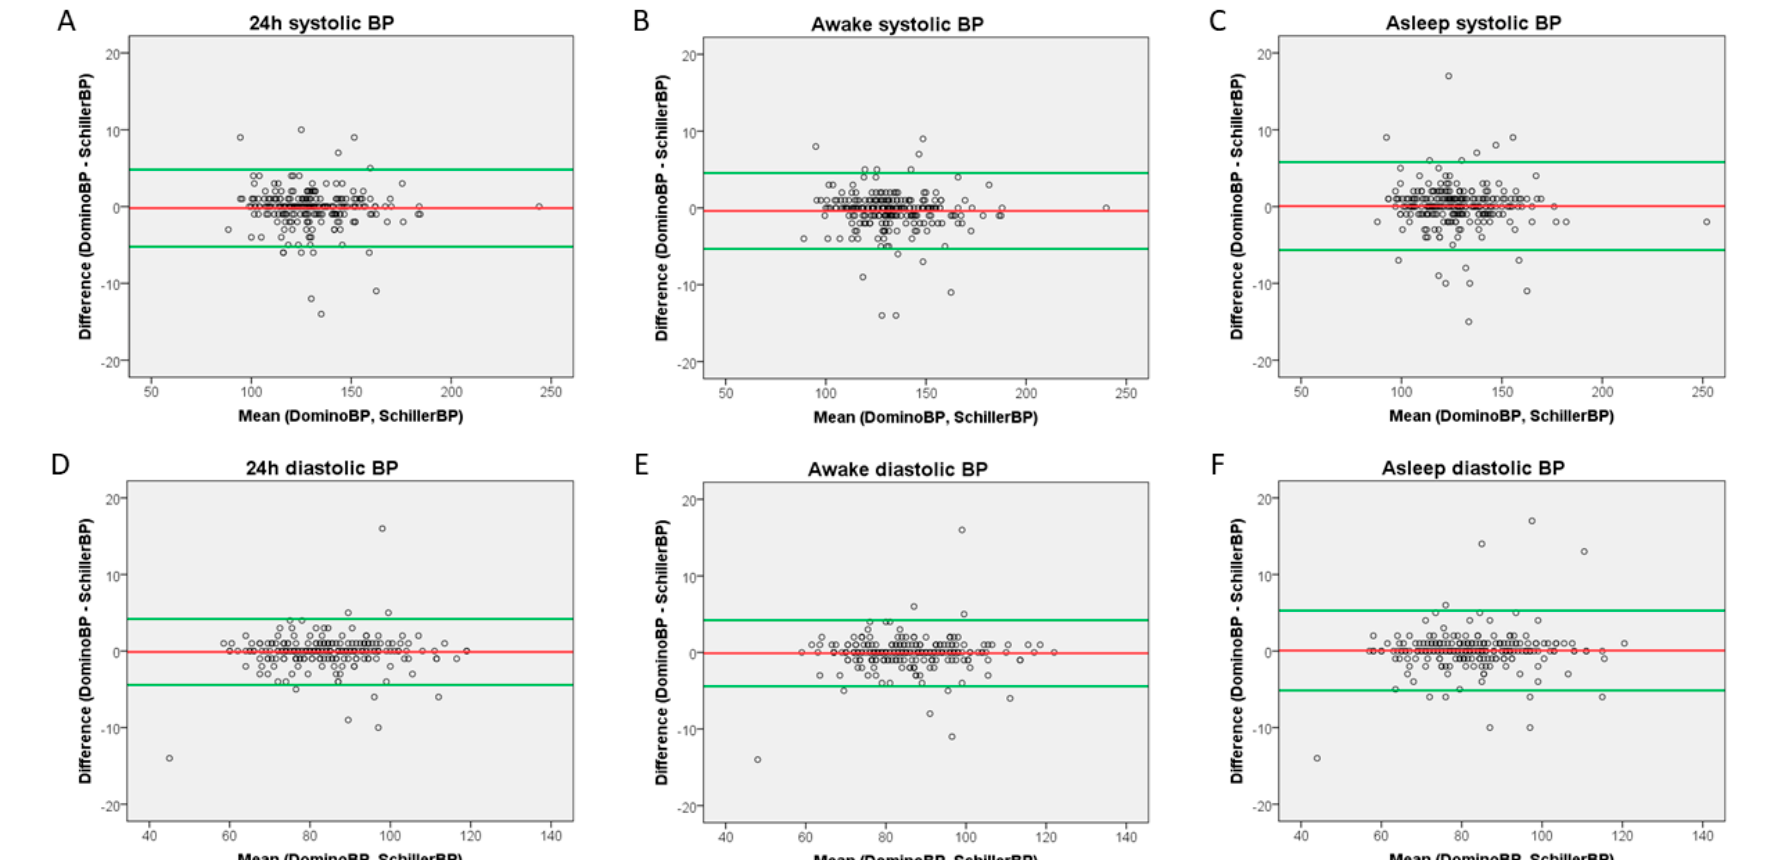
Figure 2. Bland–Altman Plots. ( A ) 24-hour systolic measurements, ( B ) awake systolic measurements, ( C ) asleep systolic measurements, ( D ) 24-hour diastolic measurements, ( E ) awake diastolic measurements, ( F ) asleep diastolic measurements.